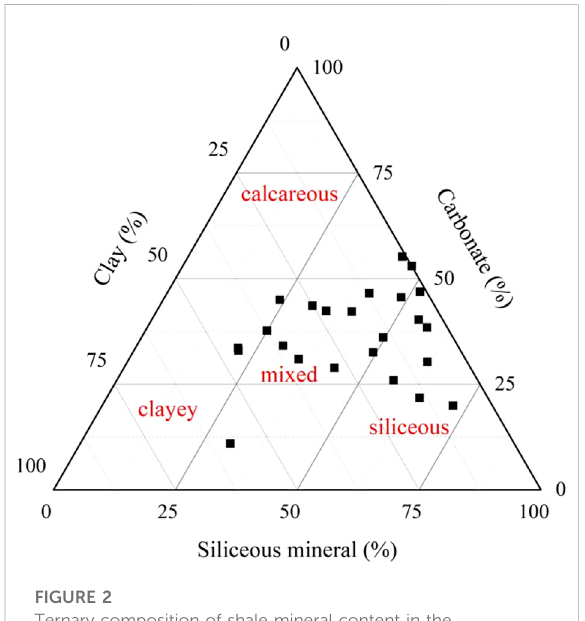
FIGURE 2 Ternary composition of shale mineral content in the Longmaxi Formation in the study area.